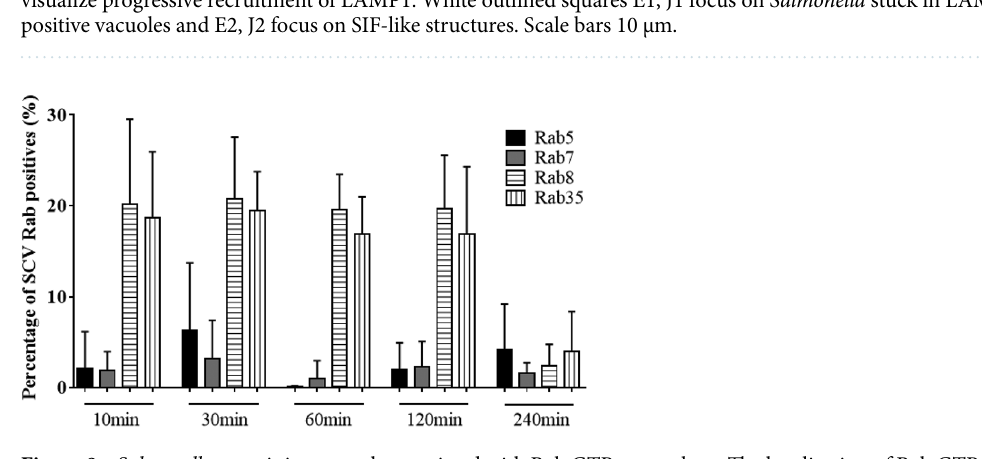
Figure 8. Salmonella containing vacuole maturation occurred in the presence of LAMP1 and led to SIF formation. The kinetics of LAMP1 recruitment was imaged for AML12 cells infected with ST DsRed and ST Δ invA DsRed at ( A , F ) 2 h, ( B , G ) 4 h, ( C , H ) 6 h, ( D , I ) 12 h and ( E , J ) 16 h pi. At each time point, cells were fixed and labelled with rat LAMP1 antibody, revealed with anti-rat Alexa Fluor 488 (green) and imaged using confocal microscopy with a 100 × oil immersion objective (Leica TCS SP8, Germany). Nuclei were counterstained with DAPI (blue). Squares outlined in white are a 2 × manual magnification of selected regions to